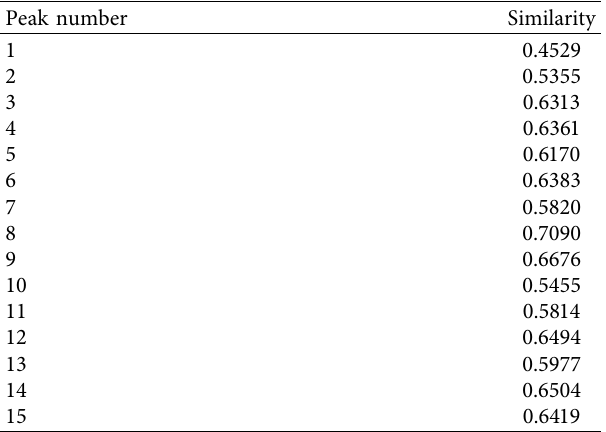
Figure 8: Results of ear swelling of Glycyrrhiza uralensis Fisch. flavonoids from 21 producing areas. The result represents mean ± S.D. Note. Compared with the normal group, ## P < 0 . 01 is a very significant difference. Compared with the model group, ∗ P < 0 . 05 was considered as significant; ∗ ∗ P < 0 . 01, and there was a significant difference ( n � 10). Table 4: Grey correlation between common peaks of flavonoids from Glycyrrhiza uralensis Fisch. and phenol red test in mouse trachea.